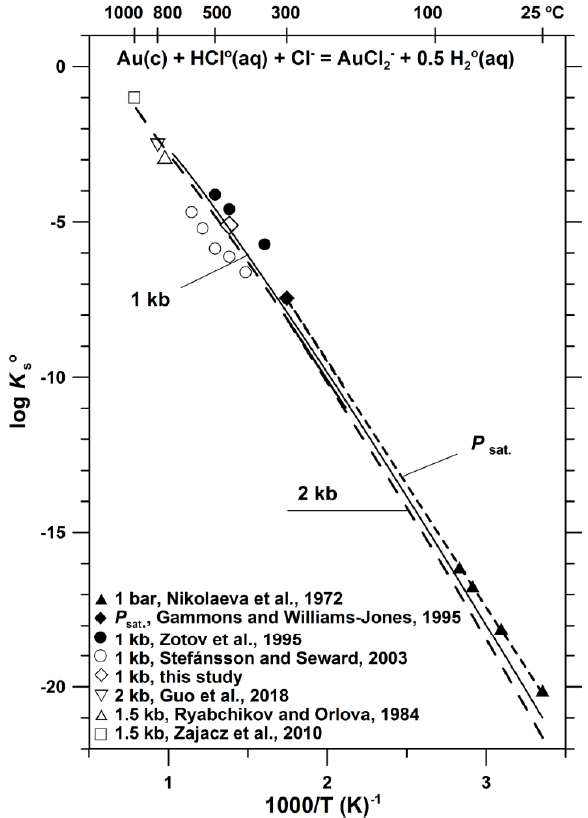
Figure 4. The Au solubility constant (Equation (3)) as a function of pressure and reciprocal temperature. Symbols are experimental data, and lines were calculated using Equation (5). The effect of pressure up to 5 kbar is shown in the insert. Table 2. Comparison of experimental values of the Au solubility constant (Equation (3)) with model values calculated using Equation (5): log K s ° = 4.302 − 7304 · T (K) − 1 − 4.77·log d (w) + 11080 ·( log